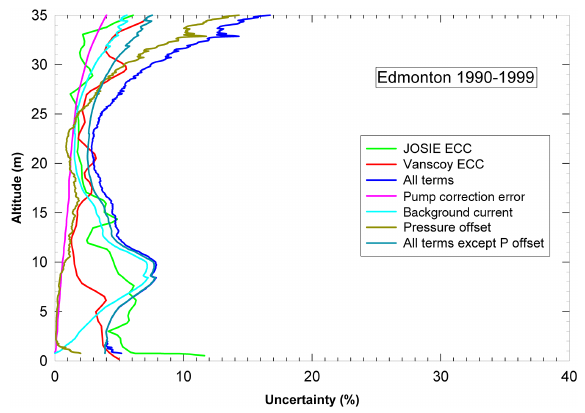
Figure 7. Average estimated uncertainty of ECC (4A and 5A) soundings in the 1990s at Edmonton, showing contributions from selected sources. The uncertainty in the VIZ or (from 1994) RS-80 radiosonde pressure measurement dominates the calculated uncer- tainty above about 28km.